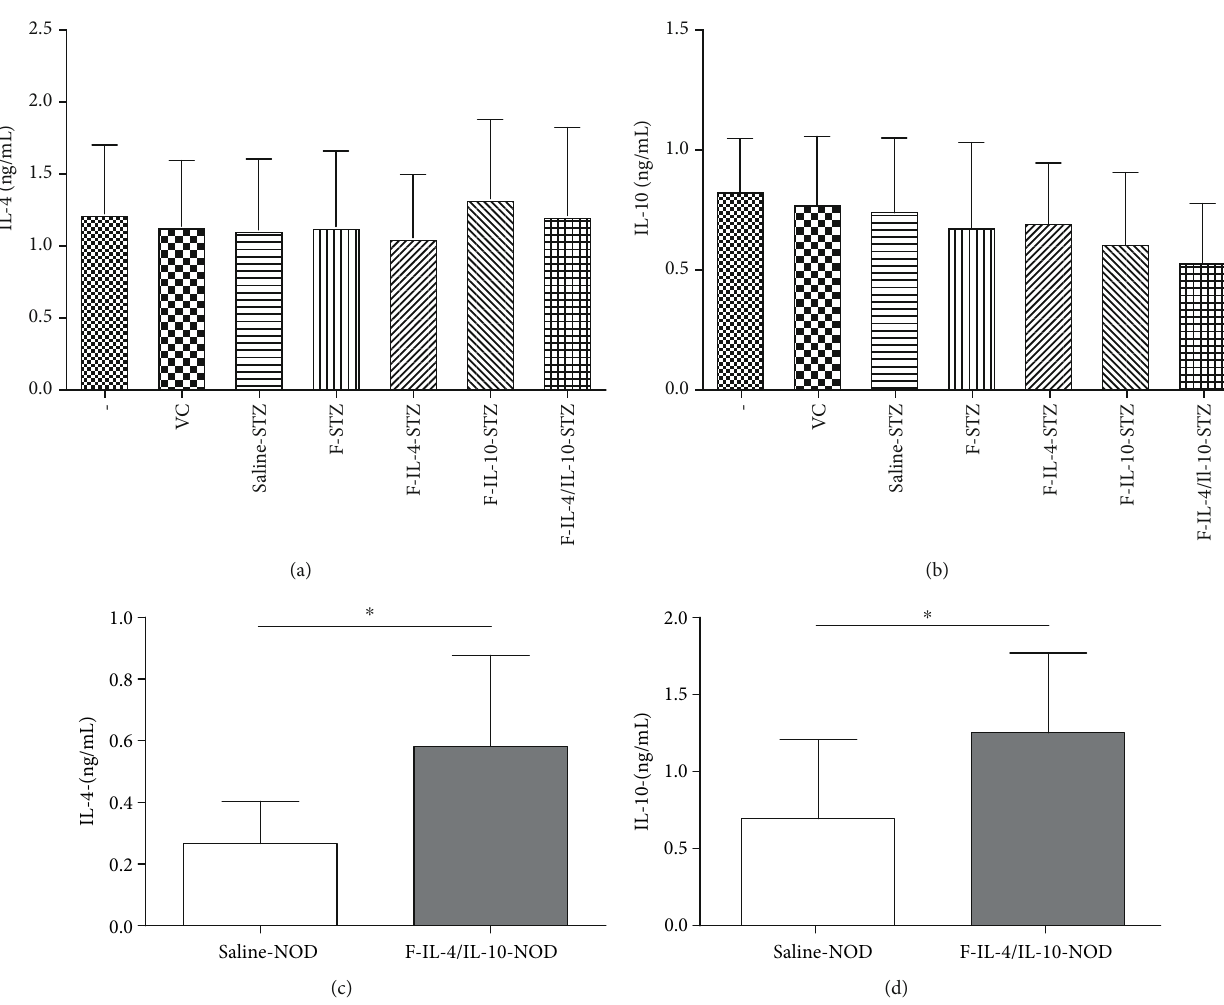
Figure 4: Serum levels of IL-4 and IL-10 from STZ-induced C57BL/6 mice and NOD mice, which were both treated with oral bacterial administration. Saline, vehicle, or STZ-injected C57BL/6 mice were euthanized at the end of the experiment, and serum was collected to measure IL-4 and IL-10 levels ((a, b), respectively, n = 18 ). After saline or oral bacterial administration, serum was collected from NOD mice after euthanasia to measure IL-4 and IL-10 levels ((c, d), respectively, n = 12 ). – : negative control; VC: vehicle control; F: mice